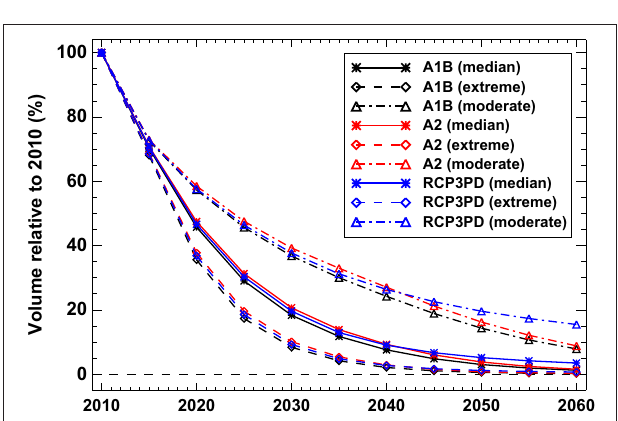
FIGURE 8 | Calculated ice volume of all very small glaciers in Switzerland relative to 2010 for three CO 2 -emission pathways (A1B, A2, RCP3PD) and the median, the extreme, and the moderate scenario.